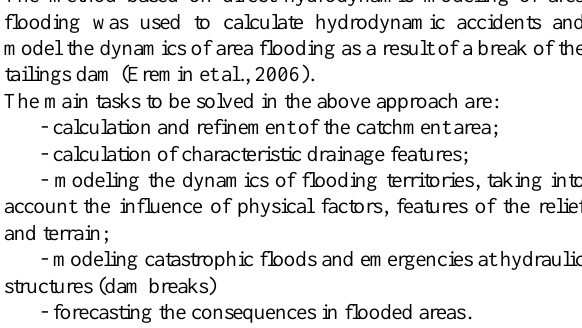
Figure 3. DEM of the simulated area (3D